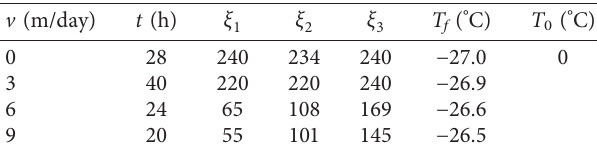
Table 2: Comparison of extended range of steady-state temper- ature field under different seepage velocities ( v